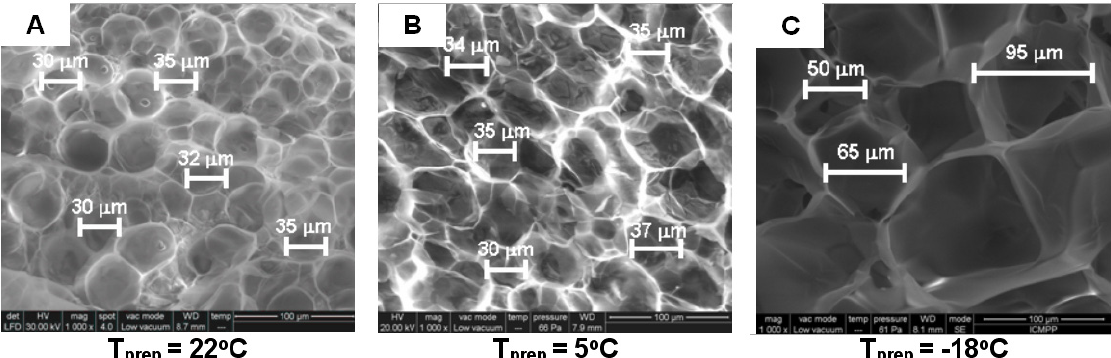
Figure 2. SEM images of the PAAm/Dx semi-IPN hydrogel disks prepared at 22 o C (A), 5 o C (B), -18 o C (C). The scaling bars are 100 µm. Mag. = 1000x.